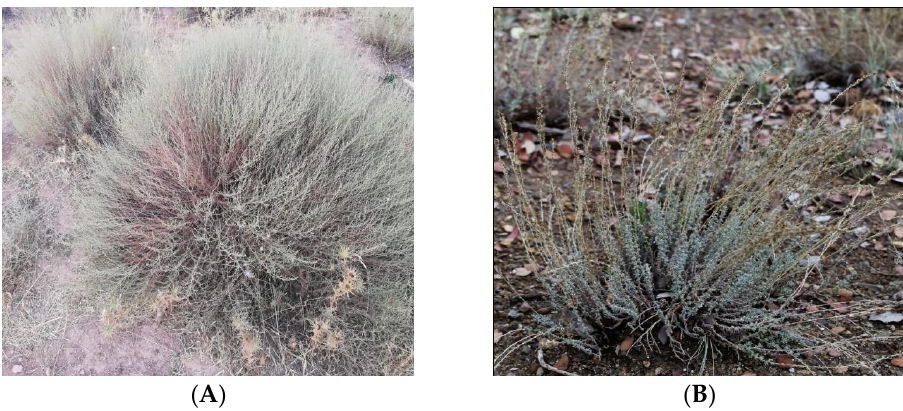
Figure 2. Morphological aspects of A. herba alba Asso ( A ) and A . mesatlantica Maire ( B ).